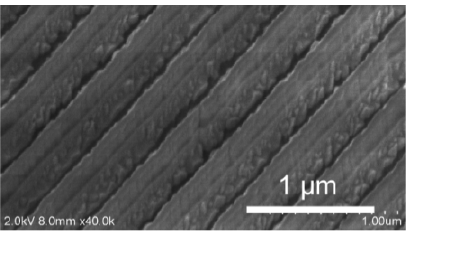
Figure 1. Surface topography SEM image of the infrared grating (groove depth = 350 nm, period ( Λ ) = 400 nm, and duty cycle (f) = 0.6) and its polarization characteristics.